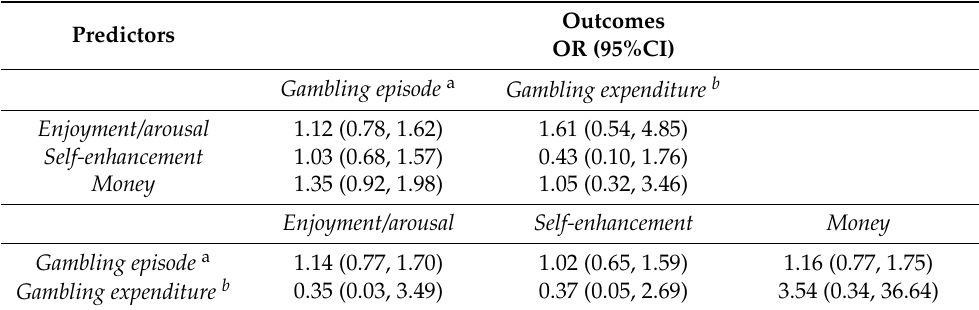
Table 4. Mixed effects binary logistic regressions exploring the reciprocal relationships between EMA gambling outcome expectancies and gambling behaviour.